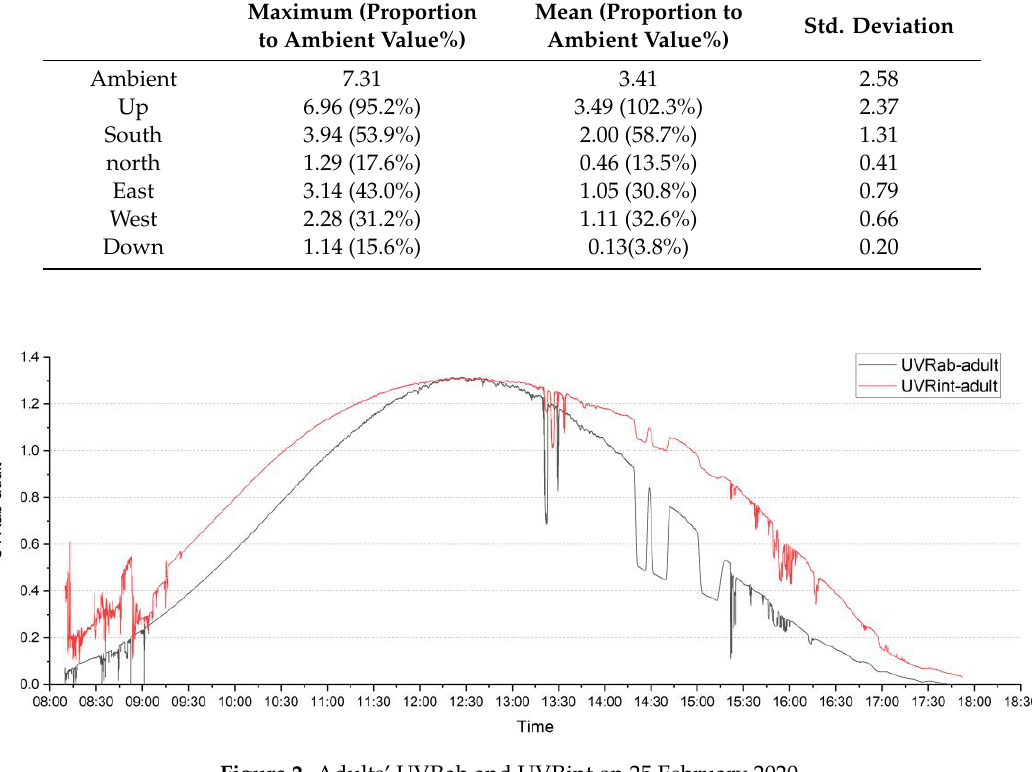
Figure 2. Adults’ UVRab and UVRint on 25 February 2020.